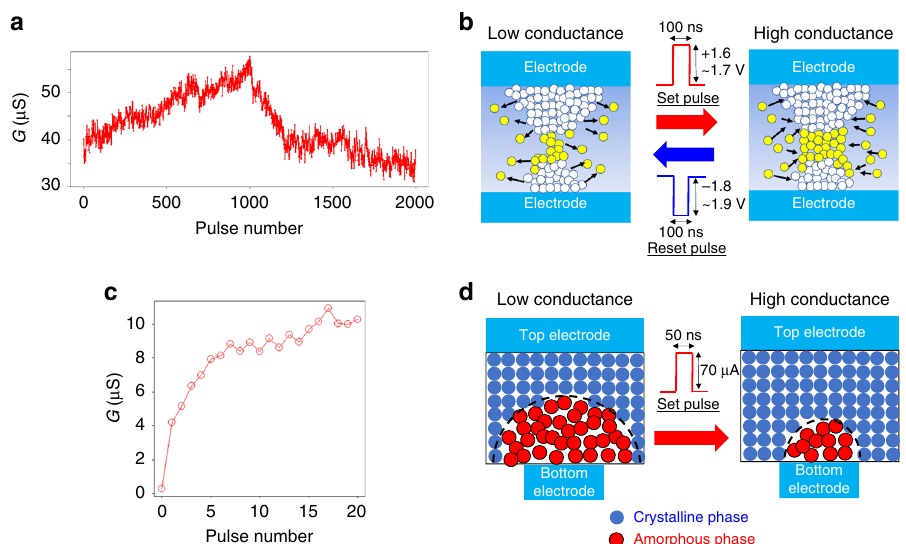
Fig. 2 Analog switching behaviors of ReRAM and PCM. a Device G as a function of pulse number for our HfO 2 -based ReRAM device. 1000 consecutive set pulses, followed by 1000 consecutive reset pulses were applied on the top electrode. b The change of G is attributed to change in the con fi guration of the current conducting fi lament which consists of oxygen vacancies as schematically illustrated. c Device conductance G as a function of pulse number for our GST-based PCM device. A total of 20 consecutive set pulses were applied. d The G increase in response to set pulses corresponds to the transition from the amorphous phase to the crystalline phase of GST as schematically